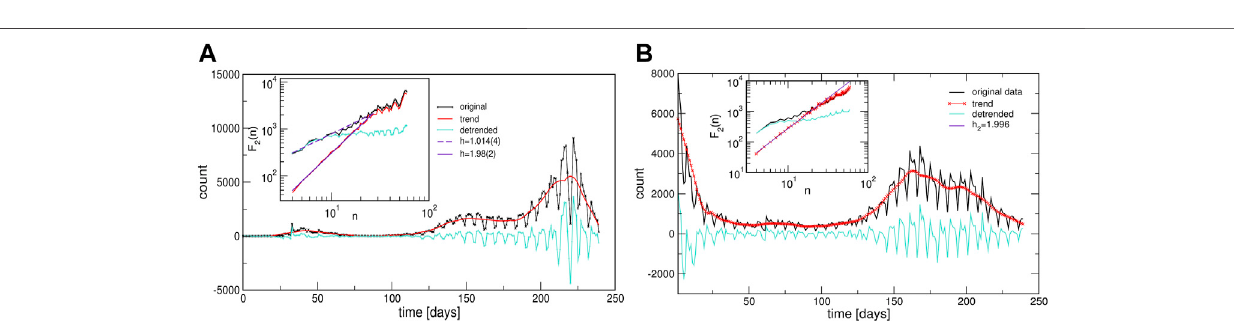
Frontiers in Physics |